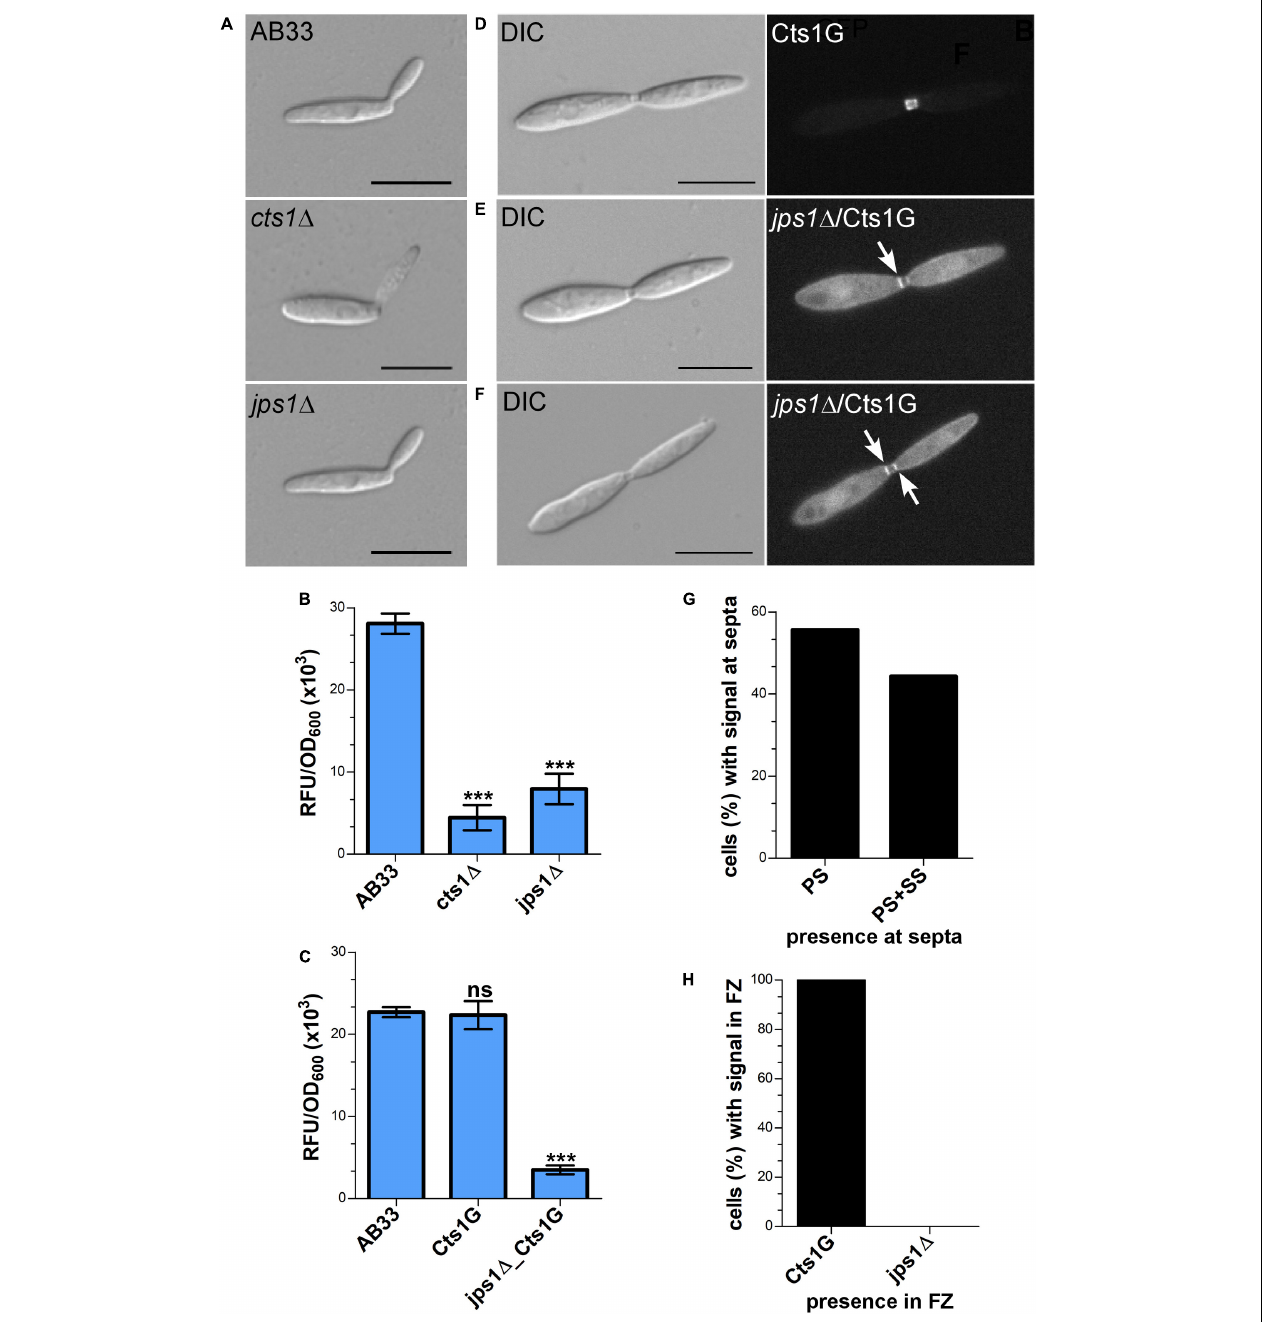
FIGURE 4 | Jps1 is crucial for unconventional Cts1 secretion. (A) Micrographs of yeast-like growing cells of indicated strains. The jps1 deletion strain AB33jps1 (cid:49) (jps1 (cid:49) ) does not show any morphological abnormalities. The cts1 deletion strain AB33cts1 (cid:49) (cts1 (cid:49) ) and the progenitor laboratory strain AB33 (wt) are shown for comparison. Scale bars, 10 µ m. (B) jps1 deletion in the AB33 verifies its essential function in Cts1 secretion. Extracellular Cts1 activity of AB33, AB33jps1 (cid:49) and the control AB33cts1 (cid:49) is depicted. The assay was conducted in three biological replicates. Error bars indicate standard deviation. *** P -value 0.001; n.s., not significant (two sample t -test). (C) Extracellular Cts1 activity of Cts1G expressing strains are comparable to the progenitor strain AB33, suggesting that the protein is functional. The assay was conducted in five biological replicates. Error bars indicate standard deviation. *** P -value 0.001; n.s., not significant (two sample t -test). (D–F) Localization of Cts1-Gfp (Cts1G) in AB33 (D) and AB33jps1 (cid:49) (D,E) . While Cts1 accumulates in the fragmentation zone of dividing cells with two septa in AB33 (D) , it enriches in the cytoplasm and at the septa in the jps1 deletion strain. Two different scenarios were observed: Either Cts1 was found only at the primary septum at the mother cell side (E) or at both septa (F) . White arrows depict septa with Cts1 signal. Scale bars, 10 µ m. (G) Distribution of Cts1G signal at the primary septum only (PS) and at both septa (PS+SS) of dividing AB33jps1 (cid:49) cells with completely assembled fragmentation zones (AB33Cts1G: 900 cells analyzed; AB33jps1 (cid:49) /Cts1G: 1370 cells analyzed; three biological replicates). (H) Cts1G is restricted from the fragmentation zone. The graph depicts the fraction of cells in exponentially growing cultures of indicated strains with Cts1G accumulation in the fragmentation zone [similar cells analyzed as shown in (G) ].